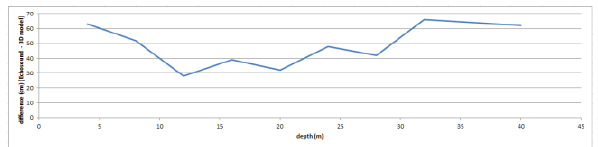
Figure 12. Trend of the differences between the